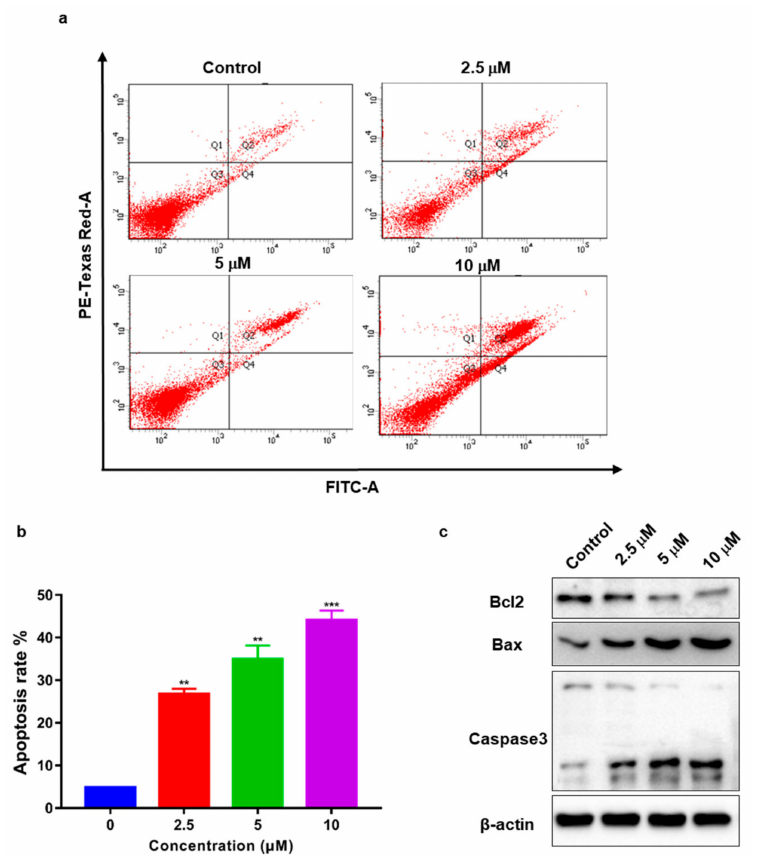
Figure 6. TSC-3C induces apoptosis in MDA-MB-231 cells. ( a ) After treatment with various concentrations of TSC-3C for 48 h, the cells were stained with Annexin V / PI and analyzed, using FACS. ( b ) After treatment with TSC-3C for 48 h, MDA-MB-231 cells were analyzed for the levels of Bcl2, Bax, and caspase-3 by Western blot. ( c ) Histogram showing the apoptotic rate of the experimental group compared with the control group. The data are expressed as the means ± SD from three independent experiments. ** p < 0.01 vs. the control group, *** p < 0.001 vs. the control